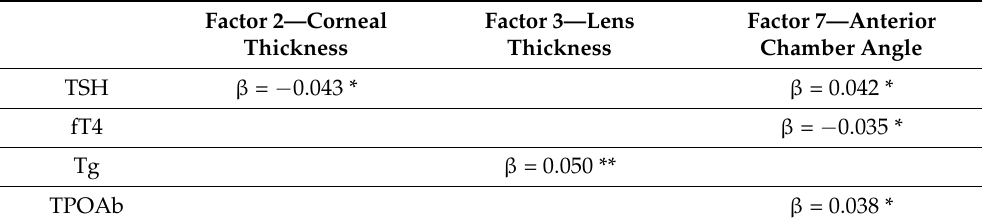
Table 3. Statistically significant associations of TSH, fT4, Tg, and TPOAb with ocular parameter groups